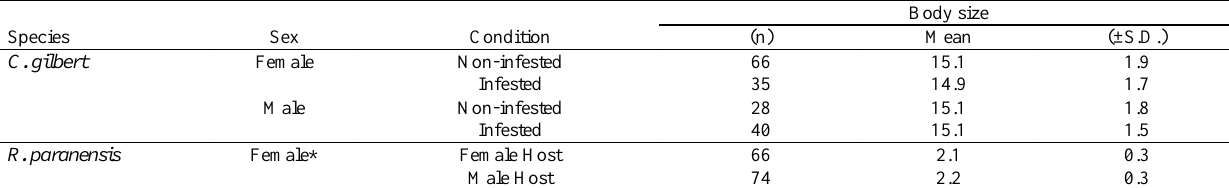
Table 1. Body size (mean and standard deviation (± SD) of the fish Cyphocharax gilbert (standard length, cm) and of the parasite Riggia paranensis (total length, mm) , from the middle Itabapoana River, Brazil. (*) Only females were parasites (Bastos & Thatcher, 1997).